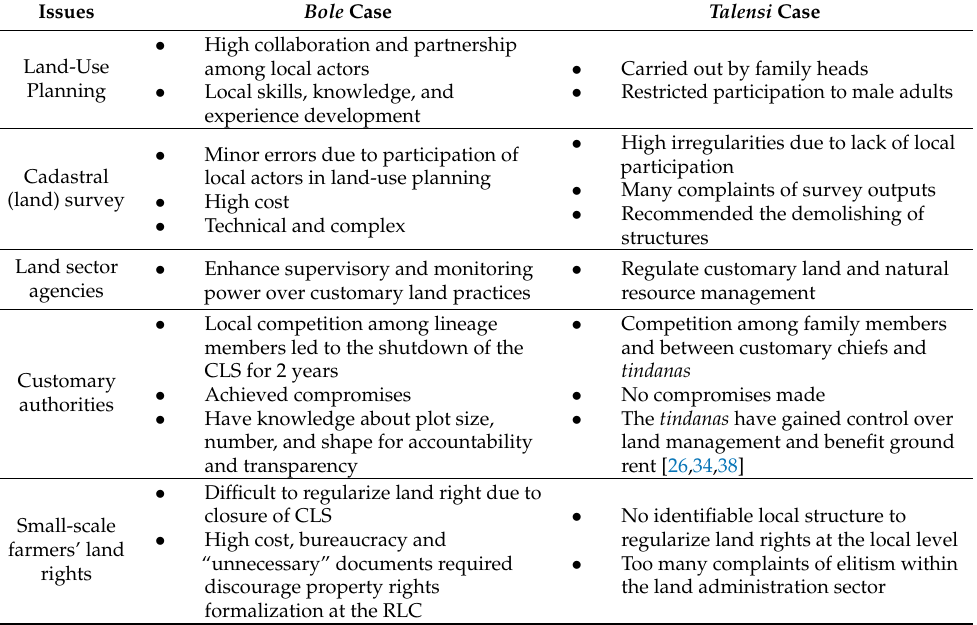
Table 2. Summary of comparative